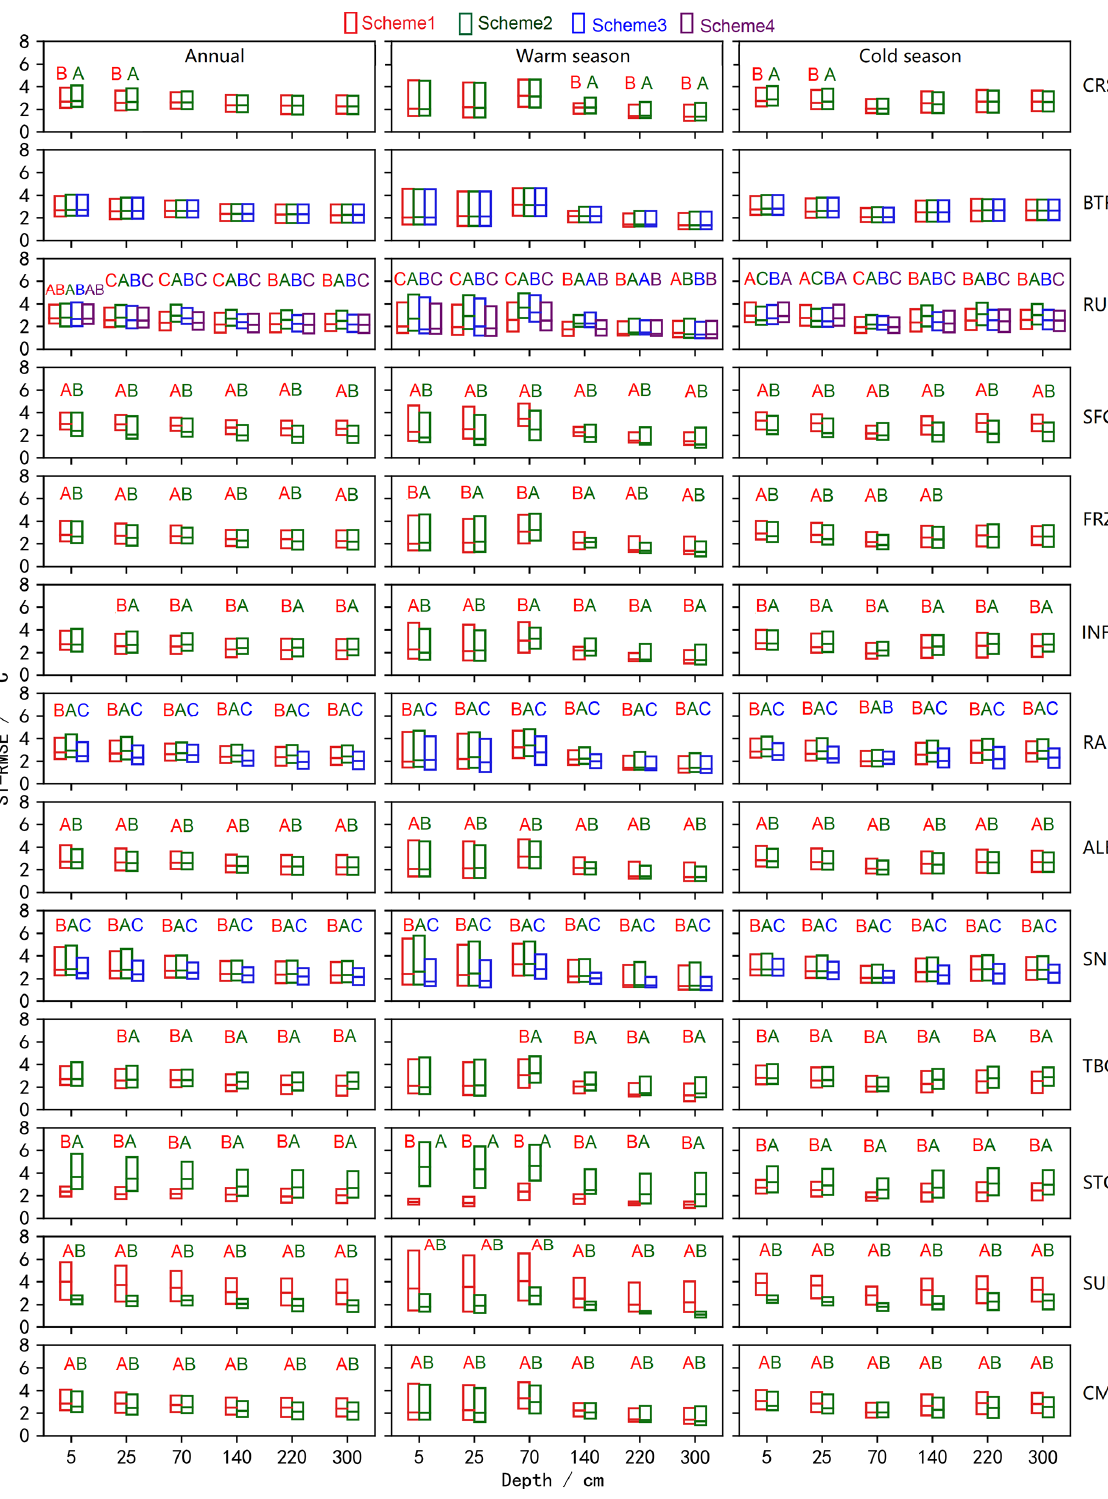
Figure 7. Distinction level for the RMSE of ST at different layers annually and during the warm and cold seasons in the ensemble simulations at the TGL site. Limits of the boxes represent the upper and lower quartiles, and the lines in the boxes indicate the median